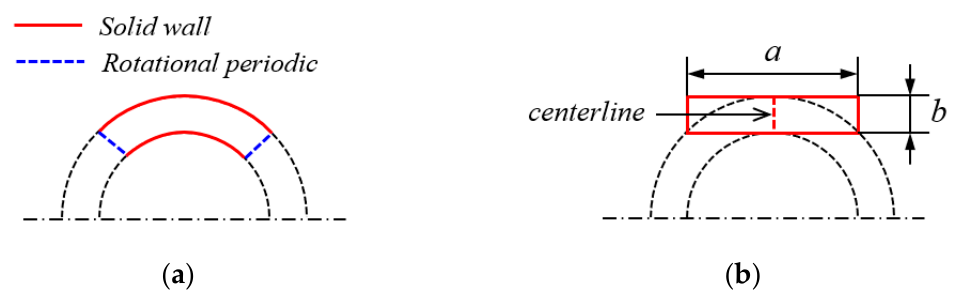
Figure 12. Simplification scheme for the VABI model (axial view): ( a ) actual bypass geometry: annular; ( b ) simplified bypass geometry: rectangular.